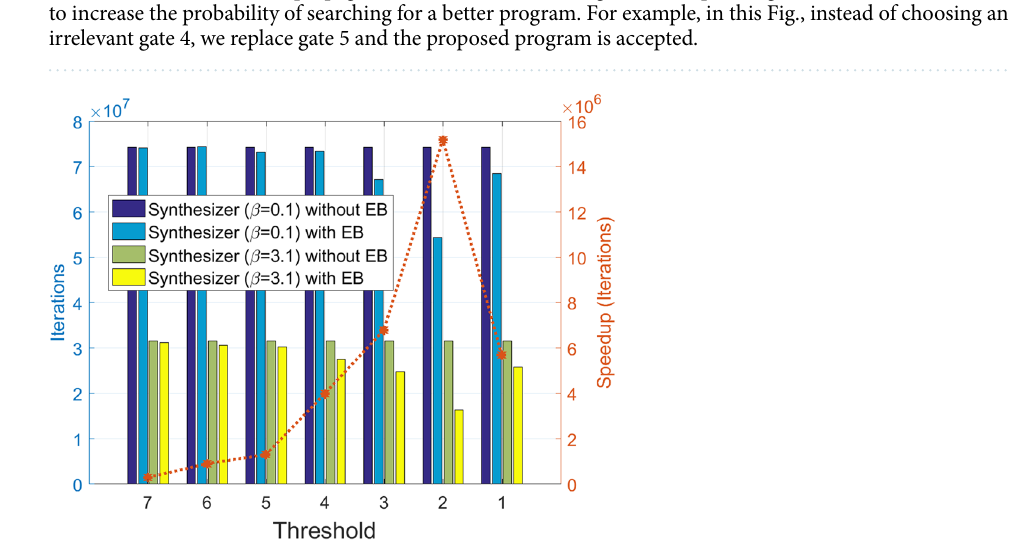
Figure 6. Performance efficiency of error backpropagation (EB). EB allows the synthesizer to replace a known faulty gate rather than guessing it at random. We show the number of iterations and the corresponding speedup (in terms of iterations) for different synthesizers while varying the threshold. The threshold is used to differentiate the normal mode and acceleration mode. If the threshold is too large, the speedup is unnoticeable as the wrong gate list contains all the gates. Replacing a gate from this list is not different from randomly selecting it. However, if the threshold is too small, it is not effective as the synthesizer takes a long time to reach the acceleration mode from the normal